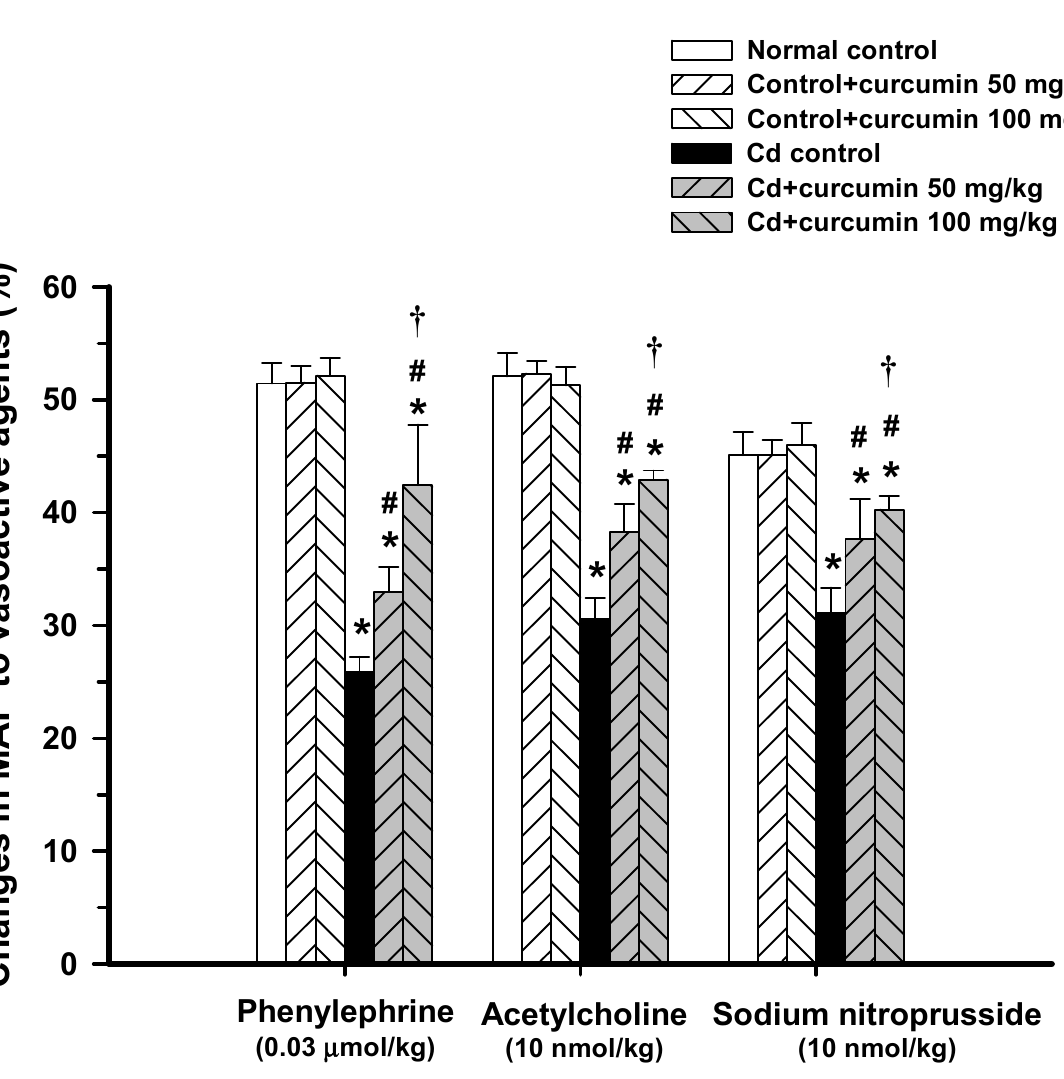
Figure 1. Effects of curcumin co-administration on vascular response to vasoactive agents, phenylephrine, acetylcholine, and sodium nitroprusside. Mice received CdCl drinking water) alone or combined with curcumin (50 or 100 mg/kg, p.o.). MAP, mean arterial pressure. Results are expressed as mean ± S.E., n = 8–10/group. * p < 0.05 compared with normal control group; # p < 0.05 compared with CdCl